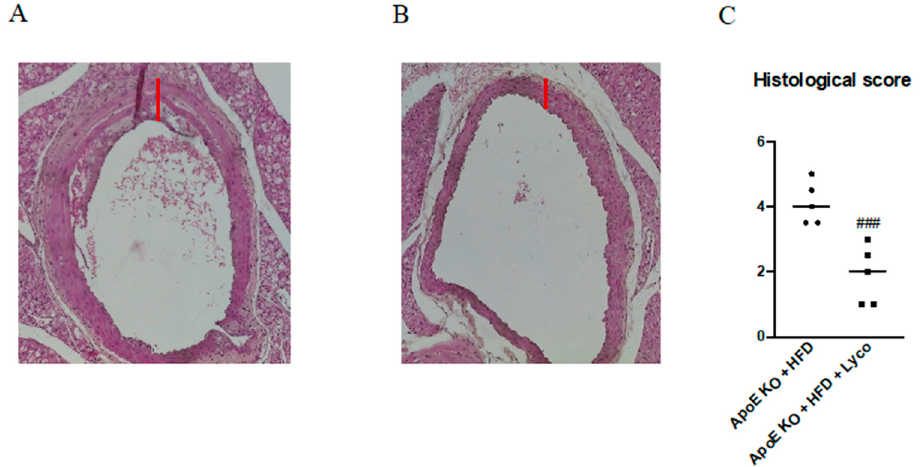
Figure 3. Representative H&E images (original magnification 10×) of thoracic aortas from ApoE KO + HFD ( A ) and ApoE KO + HFD + Lyco ( B ). The graph in ( C ) represents the histological score. Values are expressed as the mean ± SD of 5 animals. ### p < 0.0001 vs. ApoE KO + HFD.